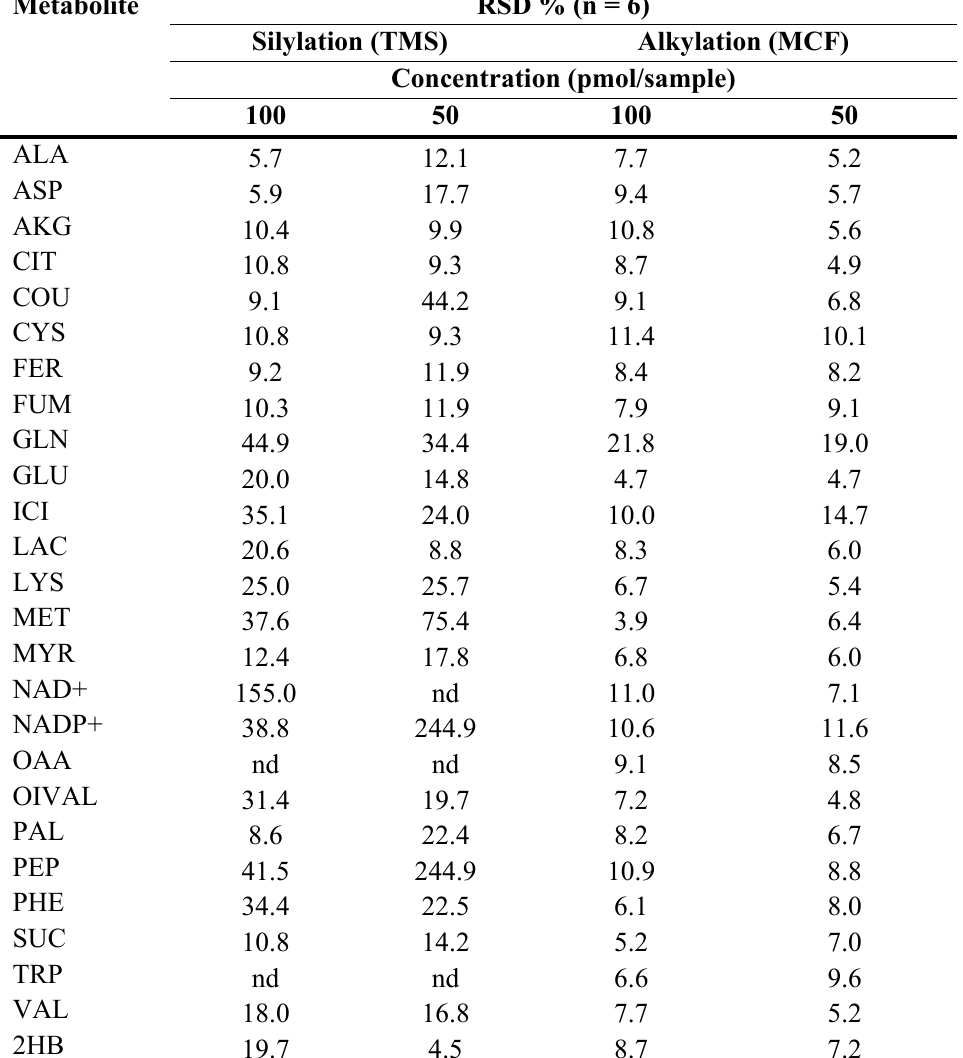
Table 3. Reproducibility (RSD) of the derivatization efficiency for several